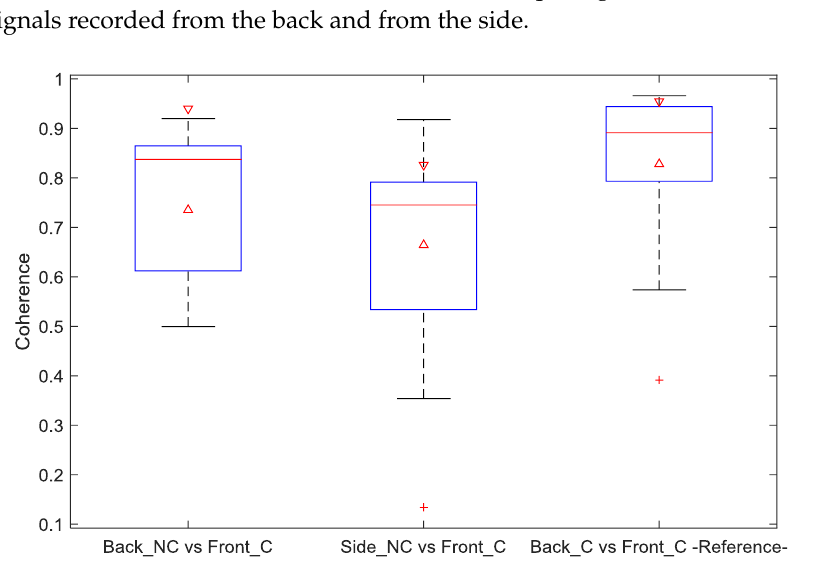
Figure 6. Correlation boxplot. Left box shows the correlation between ccECG from the back and contact ECG from the front; middle box shows the correlation between ccECG from the side (left and right) and contact ECG from the front; right box shows the correlation between contact ECG from the back and contact ECG from the front for reference on the maximum similarity of signals obtained with the same method from these two locations. ccECG signals evaluated correspond to the collection of every best segment per measurement. NC: Non-Contact; C: Contact. In addition, this comparison was also obtained for the 1-min ECG reference signals simultaneously obtained from the front and the back, as presented in the right-most box of each boxplot; this last calculation was intended to provide information regarding which part of the difference between reference ECG and ccECG signals is explained by the location of the electrodes and not by the use of the contactless technology. The results from Figure 5 show a high coherence between ccECG and reference ECG signals, with a median of 0.83 for the ccECG signals from the back and 0.74 for the ccECG signals from the side; maximum values of 0.91 were obtained in both cases.